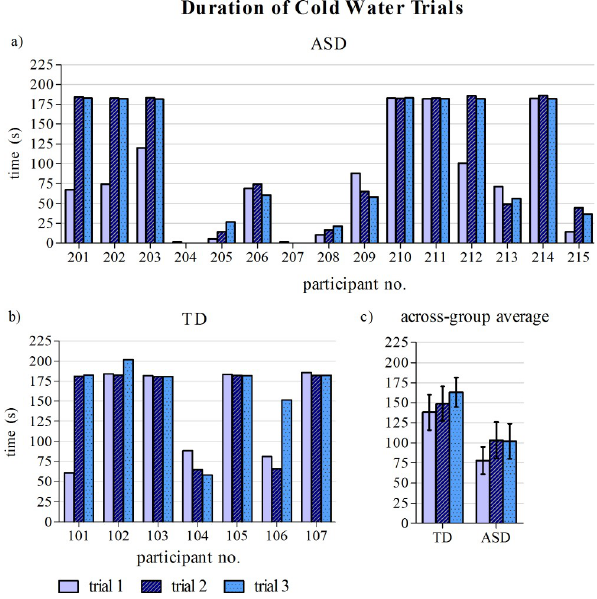
Fig 4. Duration of each of the three cold-water trials for a) TD participants b) participants with ASD and c) across- group averages. Error bars represent standard error of the mean. � indicates participant excluded from analysis of functional brain